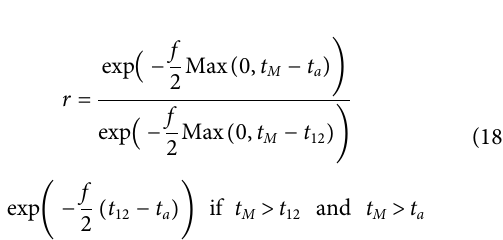
Frontiers in Earth Science |